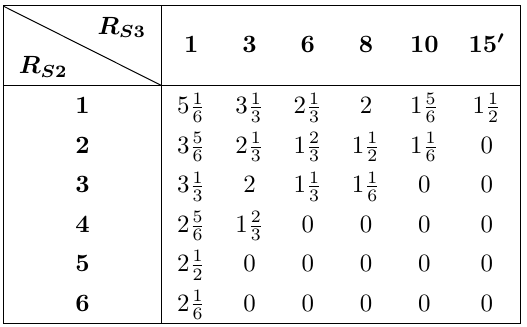
report instead the maximal value of the hypercharge allowed by perturbativity of g single pair of VL fermions ( N